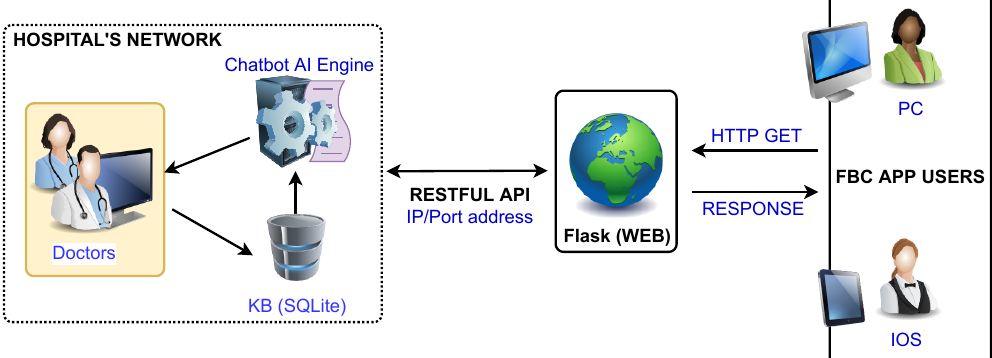
Figure 1. A simple network structure on how SAC connects prospective FBC patients to the healthcare